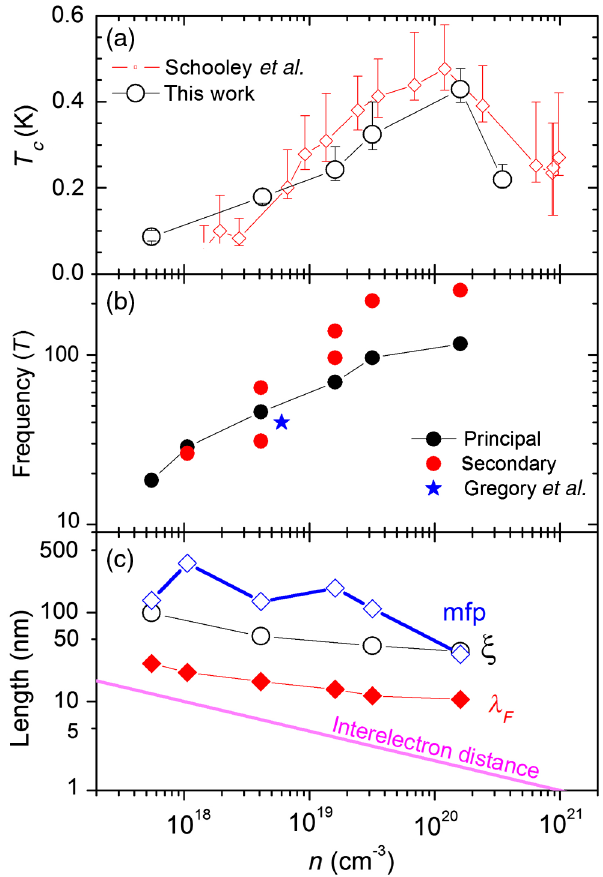
FIG. 6. (a) Variation of the critical temperature with carrier concentration according to this work and Ref. [11]. The width of the superconducting transition in each case is represented by error bars. (b) Evolution of detected frequencies as a function of doping. For carrier concentrations larger than 10 18 cm (cid:2) 3 , the oscillations display more than one frequency. The frequency and carrier density reported in Ref. [16] are also shown. (c) Variation of four relevant length scales, namely, the electronic mean free path (mfp), the average Fermi wavelength (cid:4) F of the electrons of the main band, the superconducting coherence length (cid:5) , and the interelectron